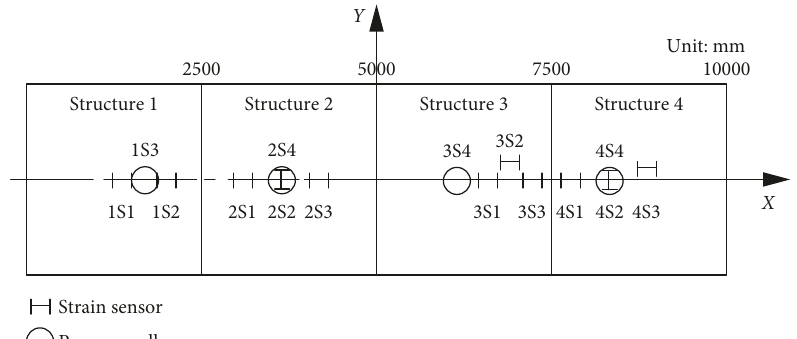
Figure 7: Embedded